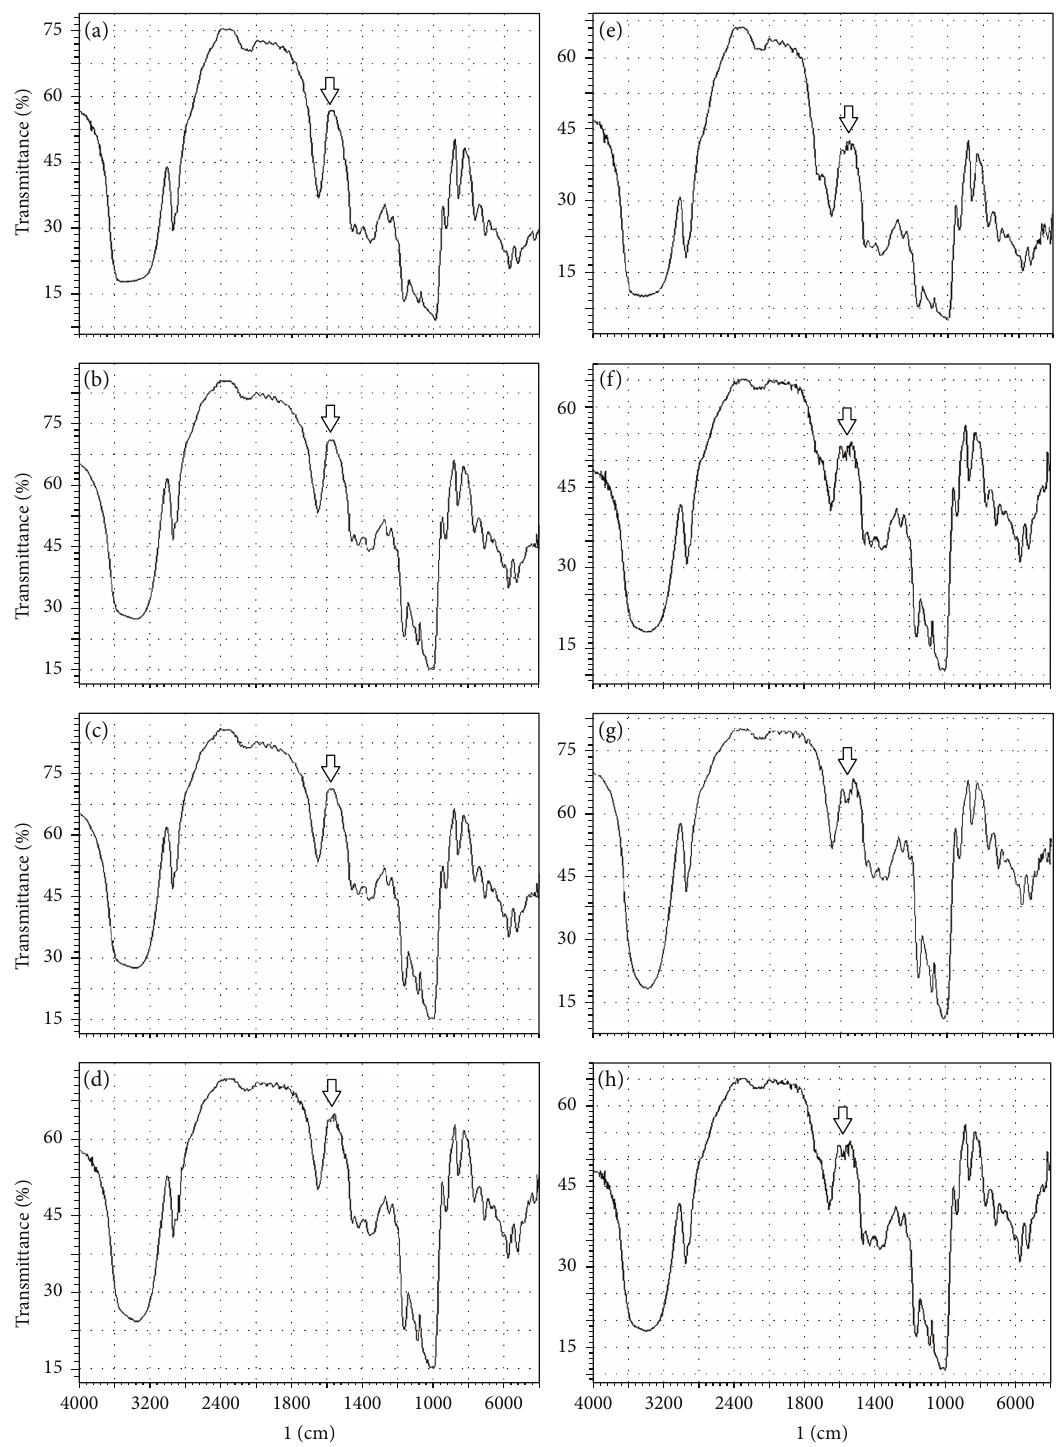
Figure 3: FTIR diagram for native and modi fi ed starches: (a) native yam; (b) native corn; (c) native potato; (d) native cassava; (e) modi fi ed yam (esteri fi cation); (f) modi fi ed corn (esteri fi cation); (g) modi fi ed potato (esteri fi cation); (h) modi fi ed cassava (esteri fi